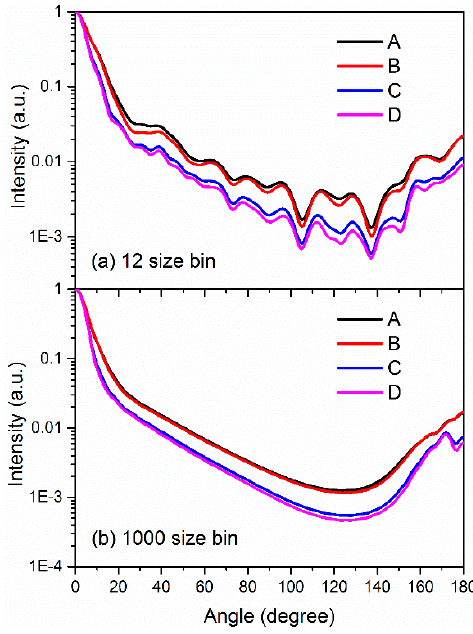
Figure 11. The simulated relative intensity distributions of the scattered light of the four samples with ( a ) the measured 12 size bin PSDs and ( b ) the fitting 1000 size bin PSDs.